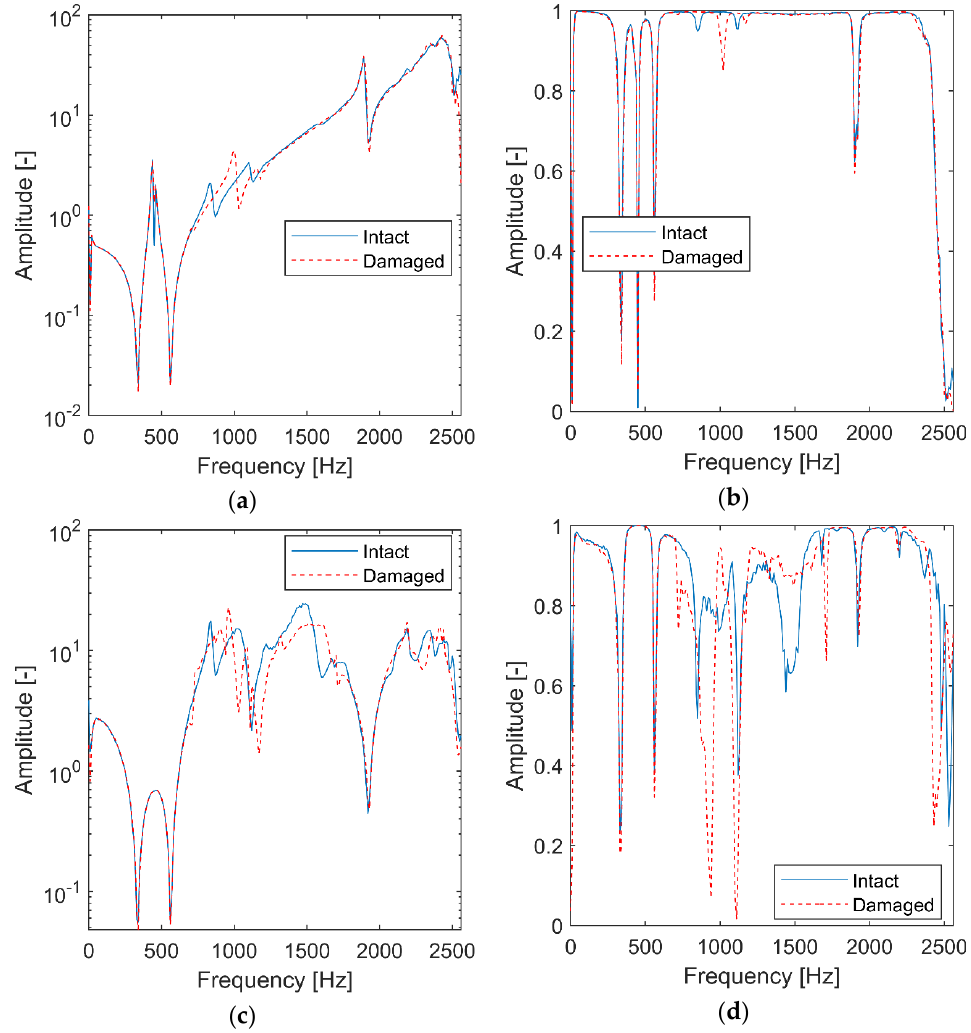
Figure 5. Classical analysis for the structural frame element: ( a ) FRF in a logarithmic scale; ( b ) FRF coherence; ( c ) transmissibility; ( d ) transmissibility coherence.